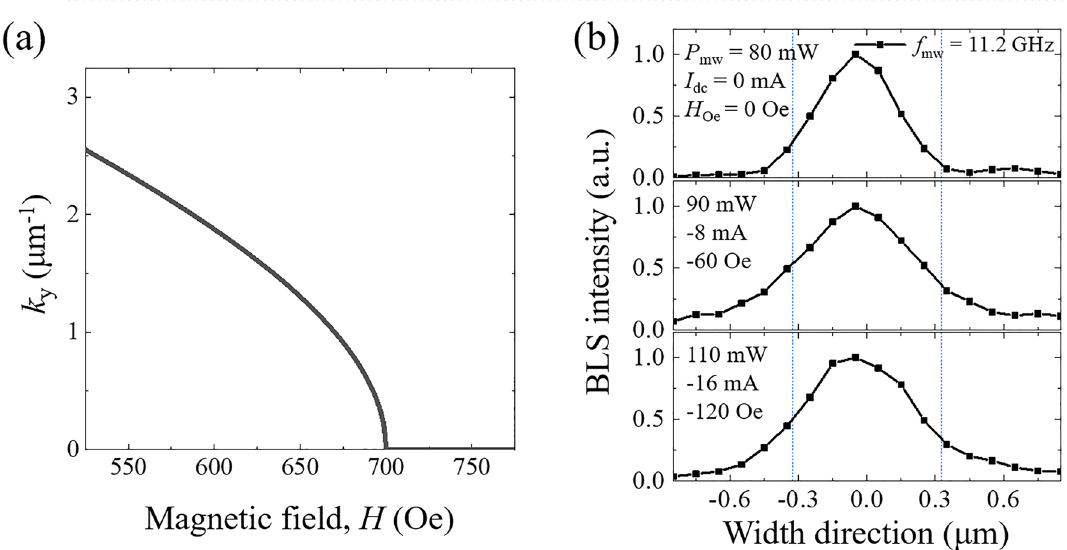
Figure 4. (a) Field dependence of the longitudinal wave vector k y at a fixed frequency of f sw = 5.6 GHz. (b) Mode profiles along the width direction. BLS intensities are measured at the frequency of f sw = 5.6 GHz. The measurement conditions of the microwave power ( P mw ), dc current ( I dc ) and Oersted field ( H Oe ) are shown in each profile. The microwave frequency ( f mw ) is 11.2